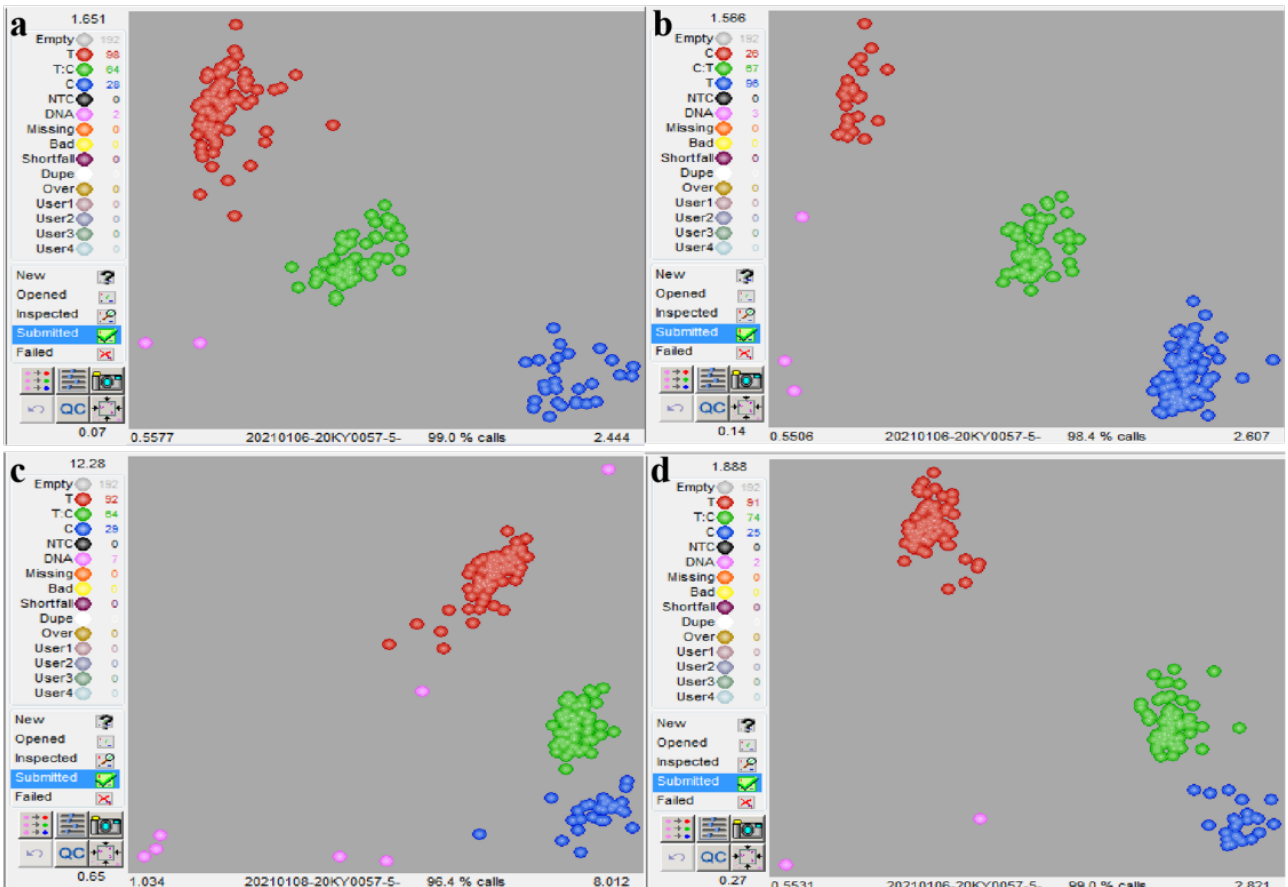
Figure 3. Verification of the candidate genes by KASP in F 2 individuals. ( a ) The genotype result at the SNP location of A07: 26905702. ( b ) The genotype result at the SNP location of A07: 27571059. ( c ) The genotype result at the SNP location of A07: 27921459. ( d ) The genotype result at the SNP location of A07: 28278890.